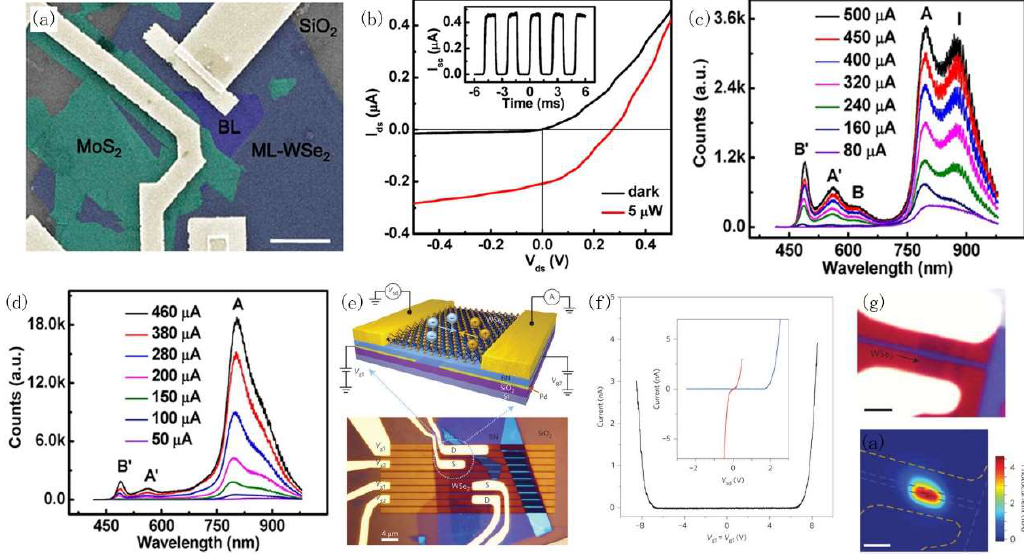
Figure 7. TMDC-based light emitting diodes (LED). ( a ) The colored SEM image and ( b ) Output characteristic of the WSe 2 /MoS 2 vertical heterojunction in the dark and under illumination [158]. Electroluminescence (EL) spectra of ( c ) multilayer-WSe 2 /MoS 2 and ( d ) bilayer-WSe 2 /MoS 2 heterojunction at different injection currents [158]. ( e ) Structure; ( f ) electrical behavior; and ( g ) microscope image and photocurrent image of WSe 2 /BN p-n junction device [153]. Most LED and excitonic devices with TMDC materials are fabricated by using the transfer-stack method. For the CVD epitaxial approach, lateral heterojunctions are easy to achieve, while the emitting area is smaller and the contact resistance is larger than for vertical heterojunctions. So the vertical heterojunction LED is more promising with regard to higher current density and brighter emitting light [154]. Wither et al. demonstrated the 2D van der Waals transfer stacks consisting of graphene electrodes, boron nitride dielectric, and TMDCs as emitters [154]. The EQE is as high as 10% in 3 to 4 multiple stacks. LEDs based on Schottky diodes usually have low EL intensity, and the EQE is in the order of 0.01% [155,160] . Cheng et al. reported the EL spectra of a vertical stack of PVD